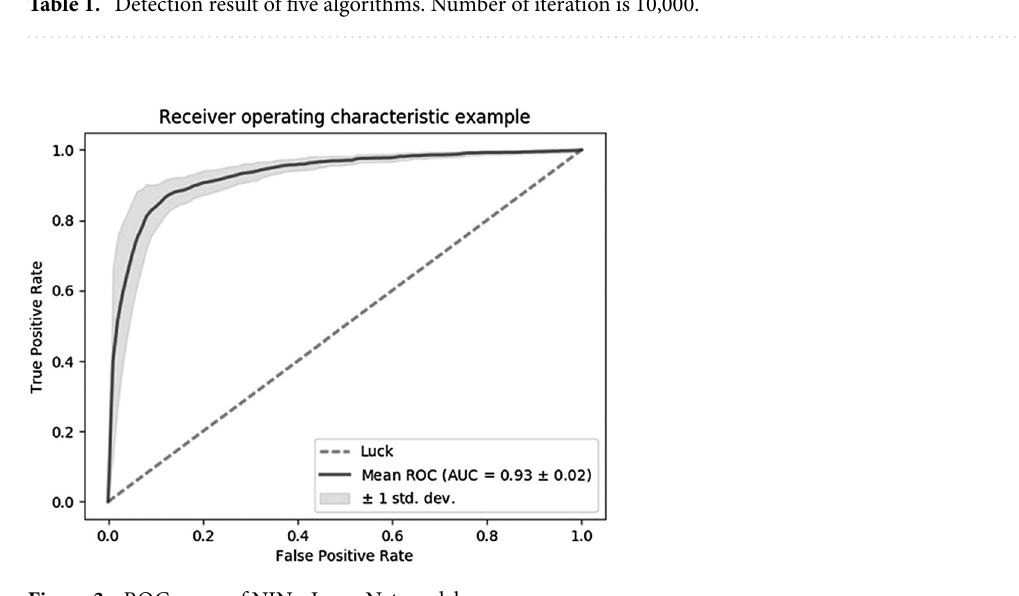
Table 1. Detection result of five algorithms. Number of iteration is 10,000.